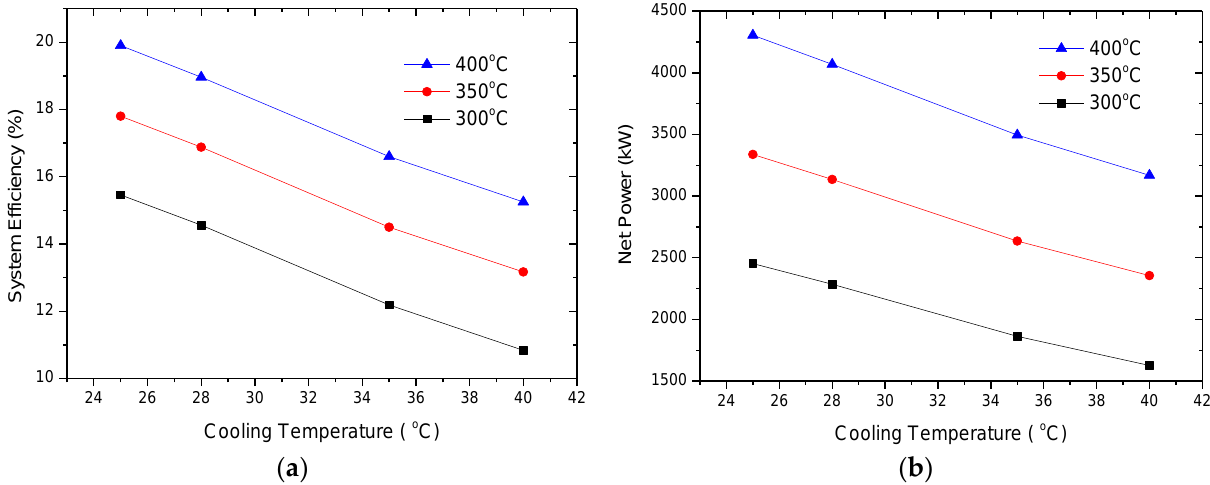
Figure 9. Performance of S-CO 2 power cycle for given exhaust gas temperature from engine: ( a ) System efficiency; ( b ) net power.